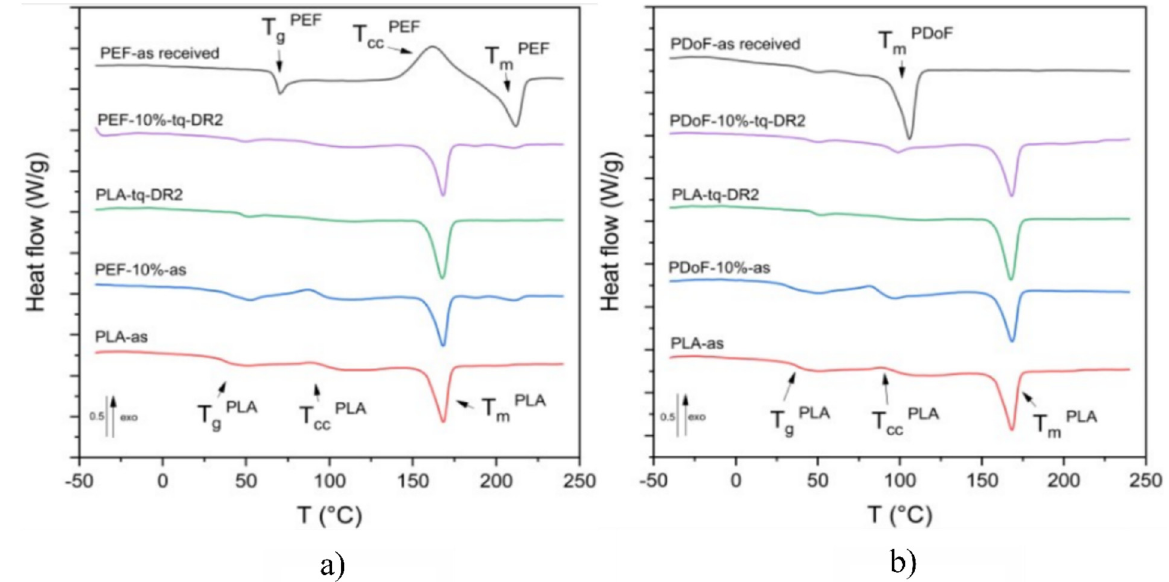
Figure 7. DSC first heating scan thermograms of: ( a ) PLA − as, PEF − 10% − as, PEF − 10% − DR2, and PEF − as received samples, and of ( b ) PLA − as, PDoF − 10% − as, PDoF − 10% − DR2, and PDoF − as received samples. Table 4. Results of DSC tests of the PLA − as, PEF − 10% − as, PEF − 10% − DR2, and PEF − as received